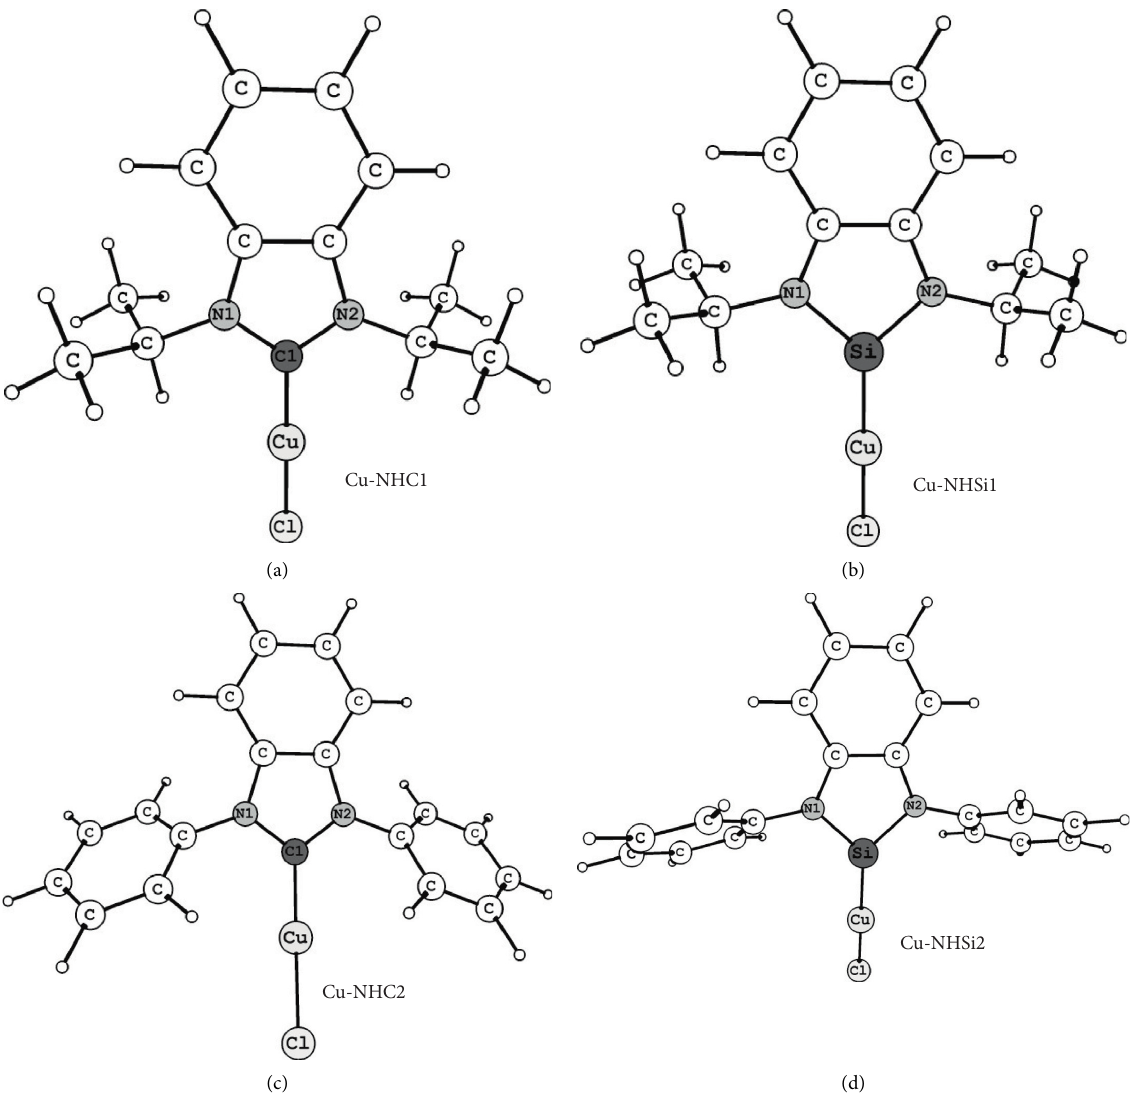
Figure 2: Structural formula of investigated complexes in this study: copper carbenes, (a) Cu-NHC1 and (c) Cu-NHC2; and copper silylenes, (b) Cu-NHSi1 and (d)